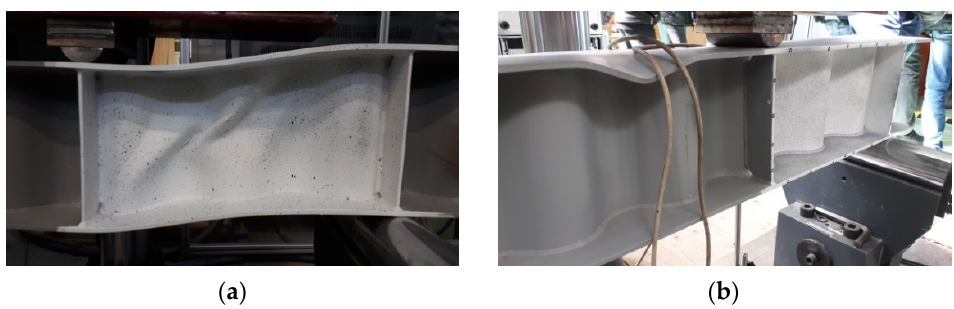
Figure 12. Forms of failure of BS 200 beams: ( a ) 3 mm-thick web and ( b ) 5 mm-thick web.